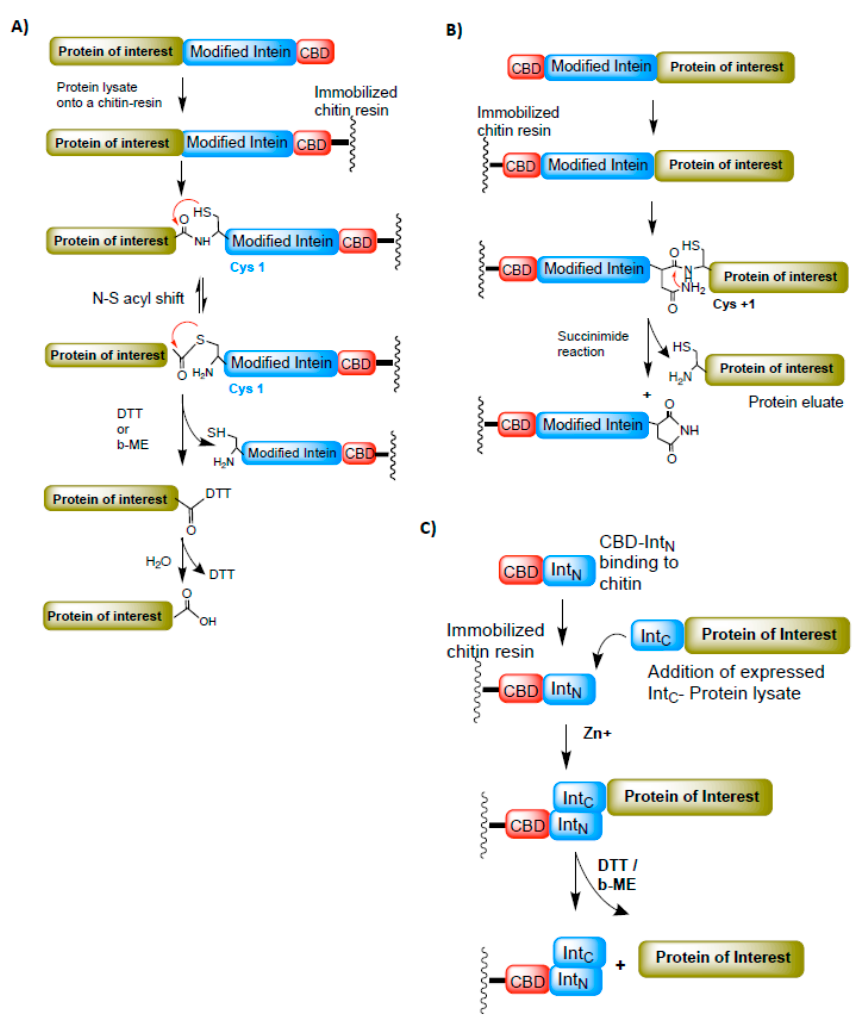
Figure 5. The intein-based protein purification techniques. ( A ) A method to purify the protein of interest (POI). The C-terminus of POI is fused to the N-terminus intein-CBD (chitin-binding domain). The POI-Intein-CBD fusion is expressed and immobilized onto the chitin resin. The POI is later cleaved from the bound intein-CBD-chitin resin by adding DTT or β -ME. ( B ) A modified intein-based purification method to purify N-terminus-fused POI attached to the C-terminus of intein-CBD domain. In this case, the POI is cleaved from the fused domain by succinimide hydrolysis. ( C ) Split intein-based purification system. The N-terminus intein (int N ) fused to CBD is immobilized onto the chitin resin and the C-terminus intein (int C ) fused to POI is allowed to trans-associate with int C -CBD domain. Zinc is added to minimize the splicing reaction during the binding process. Later, POI is cleaved off from the bound fractions by adding DTT or β -ME. Red arrows represent the chemical reaction/s between the functional groups indicated.